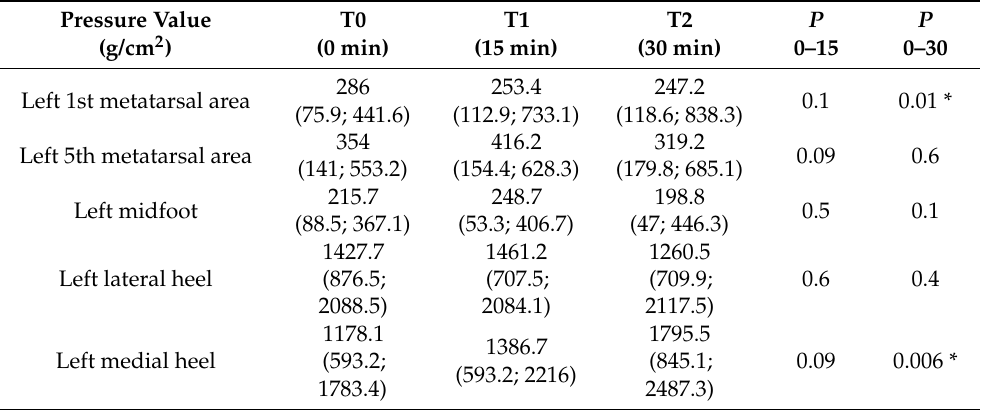
Table 2. The values of pressure recorded from the sole in the left foot (opposite side as the occlusal